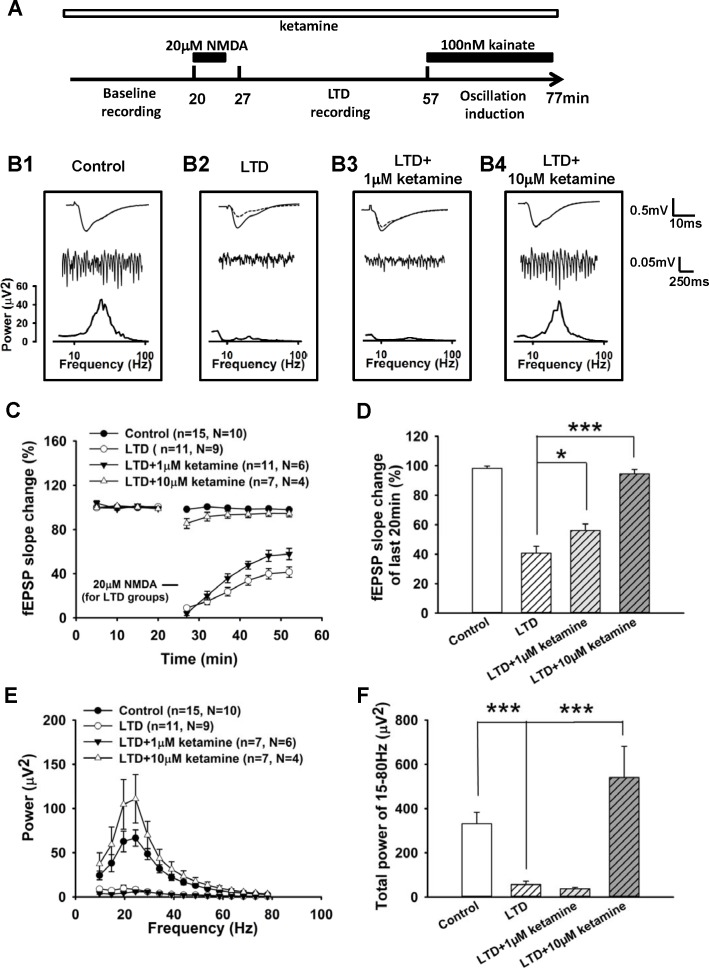
cLTD reduced hippocampal gamma oscillations and this reduction was prevented by 10 μM ketamine.A, The scheme is for the recording of both LTD and gamma oscillations in a hippocampal slice, ketamine was added at the beginning of the experiment (the unfilled horizontal bar). B1, B2, B3, B4, Representative recordings from one slice of control group (B1); LTD group (B2); LTD+1 μM ketamine group (B3); LTD+10 μM ketamine group (B4). Each column includes trace of evoked fEPSP (upper row), local field potential in CA1 (middle row) and power spectrum analysis of oscillations (lower row) from one slice respectively. Upper, representative fEPSP traces (parallel time point for control group) over averaged fEPSP of the last 20 min recording; middle, example local field potential traces showing oscillatory activity 20 min after kainate application from the same slices; lower, power spectrum of oscillations on the same slices at the same time point. C, Time-course of normalized fEPSP slope (normalized to baseline value) showing the control recording; LTD induction and the effects of 1 μM and 10 μM on NMDA-induced LTD. 5 min of 20 μM NMDA perfusion was indicated by the bar for LTD groups. D, Summarized data showing average slope change (normalized to baseline value) of the last 10 min recordings for control group, 1 μM ketamine group, 10 μM ketamine group, LTD group, LTD+1 μM ketamine group, LTD+10 μM ketamine group. E, Averaged power spectrum of 30 sec oscillations after 20 min of kainate application in control group, LTD group, LTD+1 μM ketamine group, LTD+10 μM ketamine group. F, Summarized data showing total power of 15–80 Hz oscillations in control group, LTD group, LTD+1 μM ketamine group, LTD+10 μM ketamine group. All data are expressed as mean ± SEM; *p<0.05, ***p<0.001.